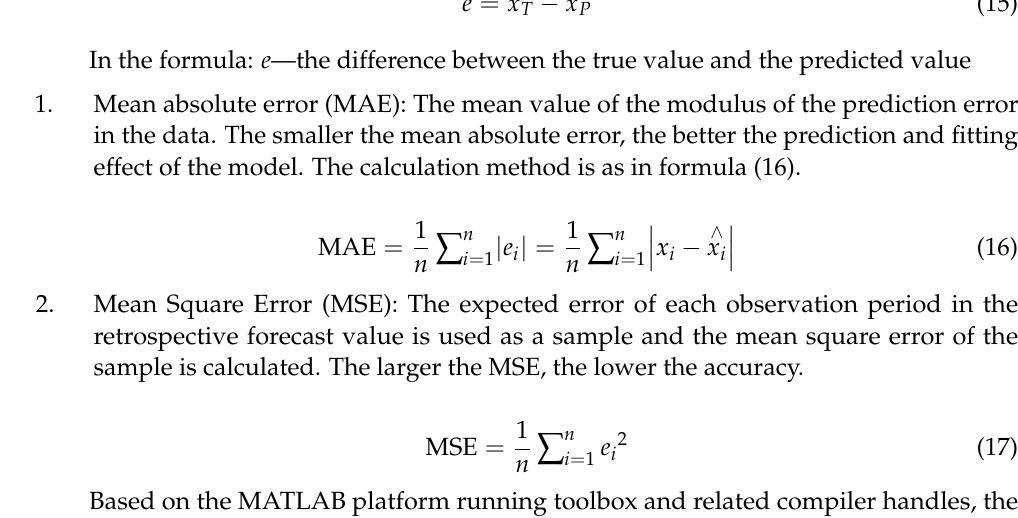
Figure 15. GA(cgp)-SVM test set data fit.